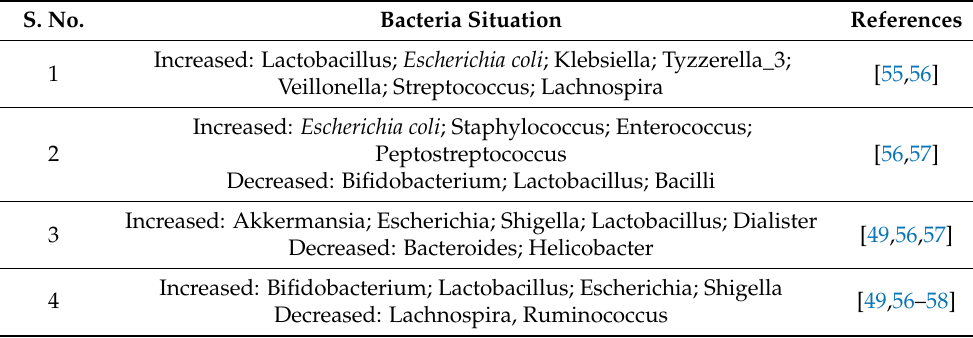
Table 2. Gut microbiome in gastric